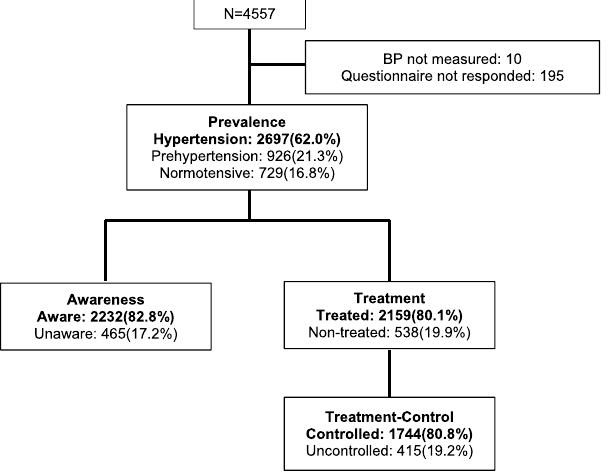
Figure 1. HTN prevalence, awareness, treatment, and control rate in Korean elderly. 62.0% elderly have HTN, and 80.1% hypertensive elderly were treated; treatment-control rate was